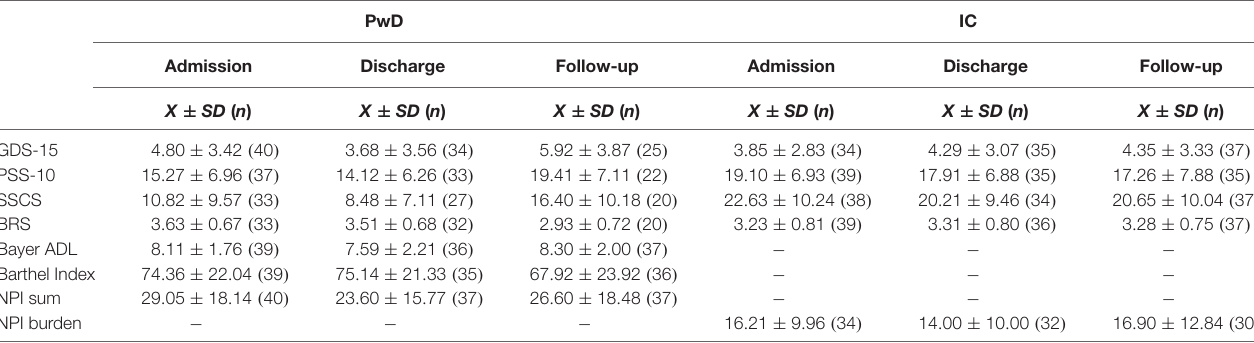
TABLE 1 | Results from psychometric test battery over time. PwD